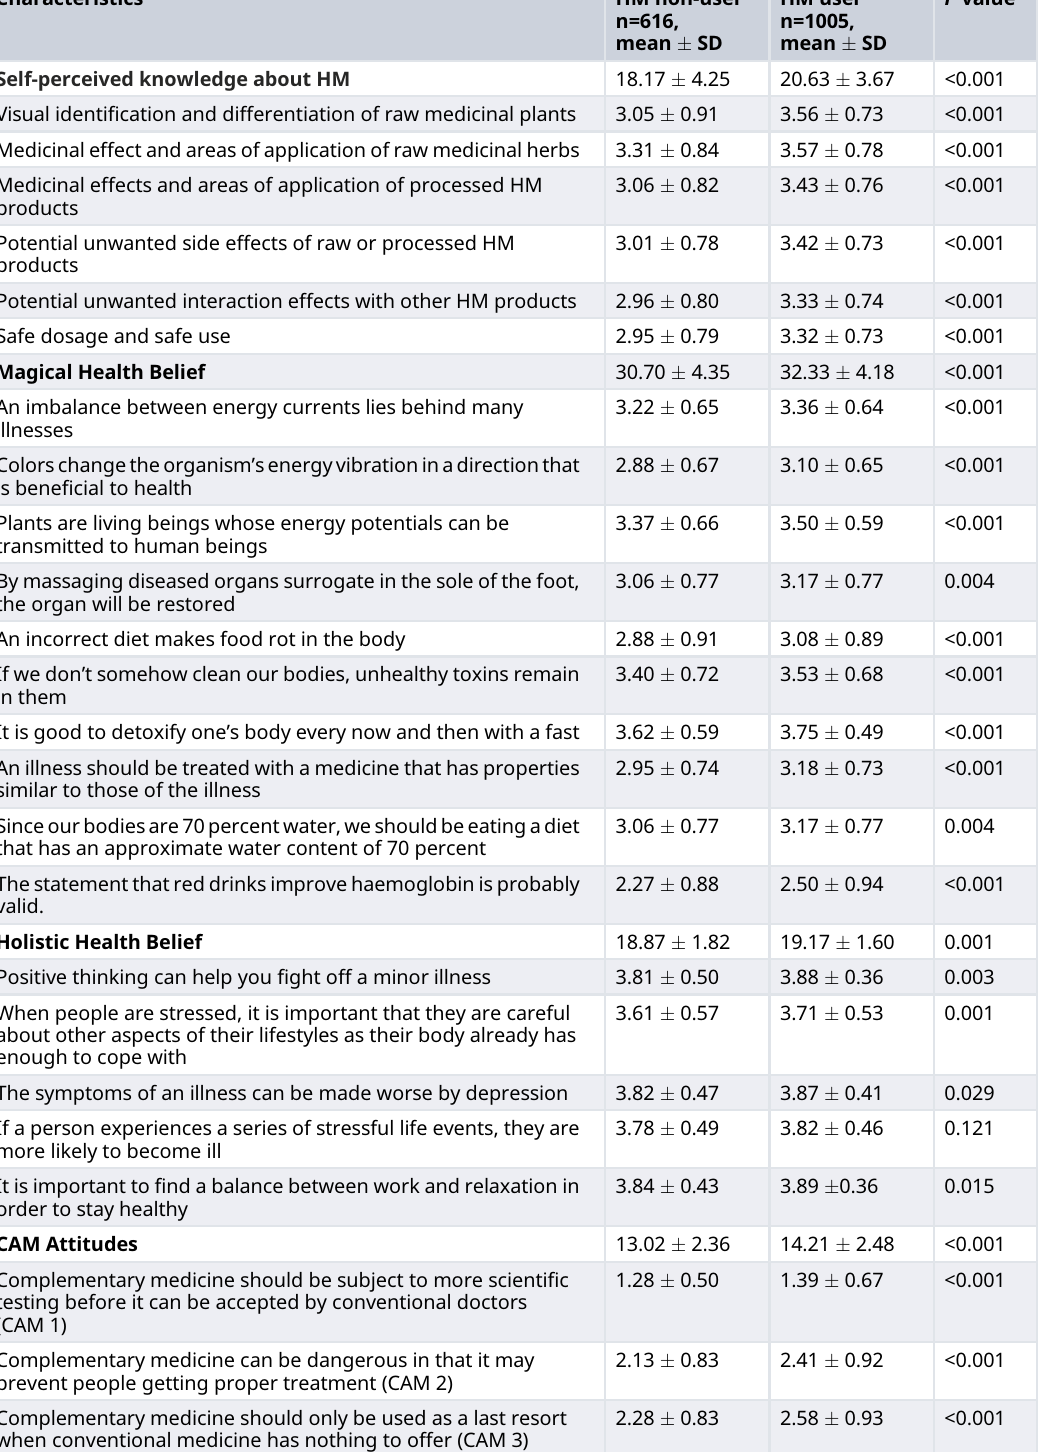
Table 2. Comparisons of citizen ’ s health knowledge, magical health belief, holistic health belief, and CAM attitudes with their herbal medicine (HM) use and HM non-user during COVID-19 pandemic (n = 1621).